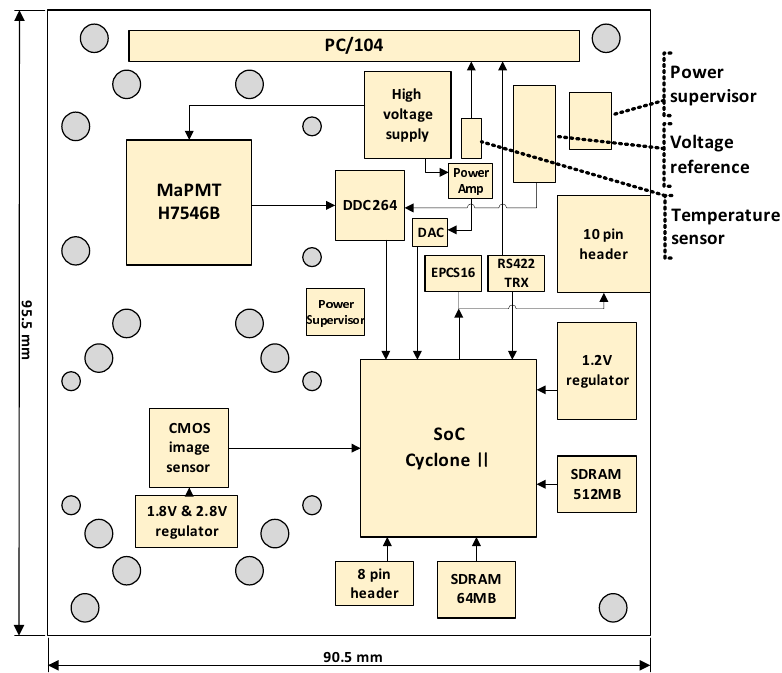
Figure 4. Board configuration of TLE observation system. It is composed of six main components: an SoC chip, an MaPMT, a high voltage supply, a DDC264 analog-to-digital converter, CMOS image sensor, and two SDRAMs.